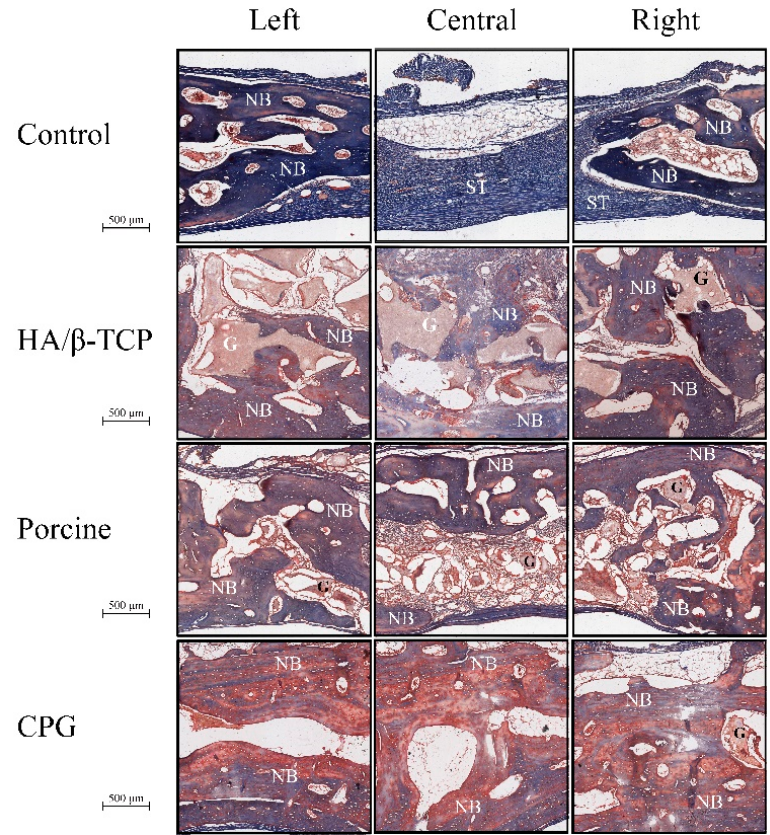
Figure 9. Histological micrographs of mid-sagittal section’s regions of interest at eight weeks. ST: soft tissue, G: graft particles, NB: new bone, OB: old bone.